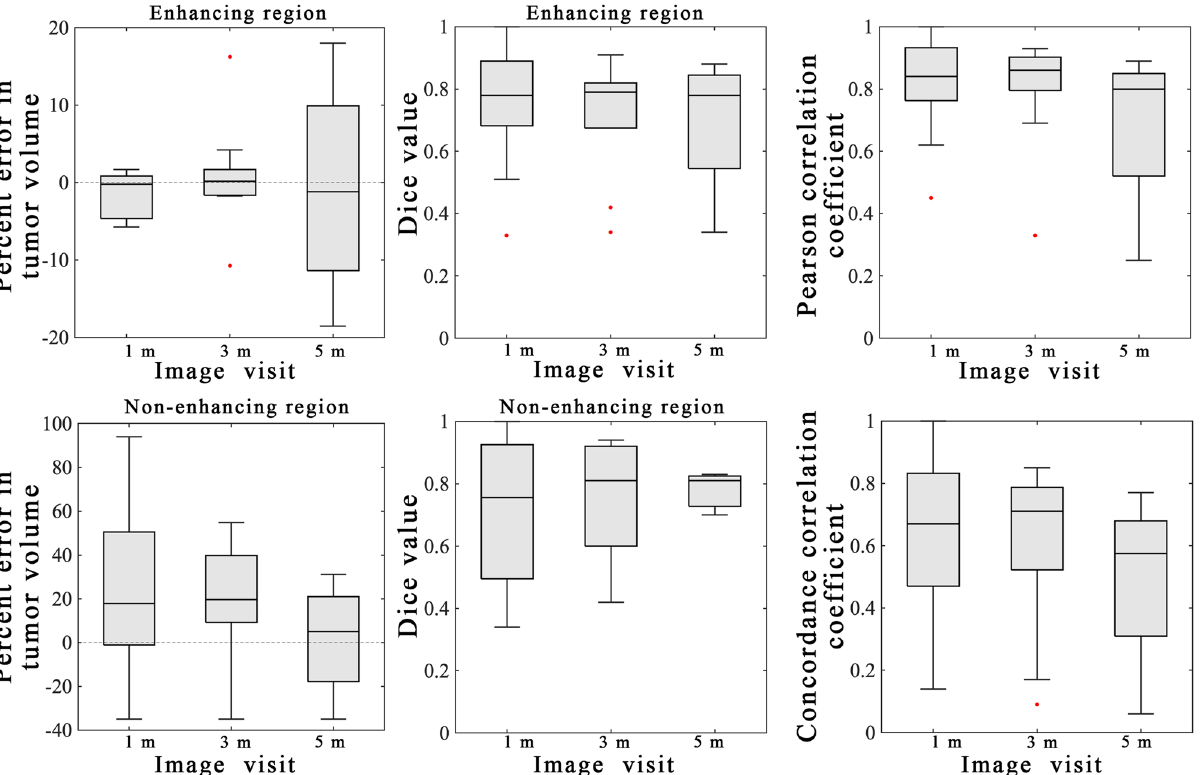
Figure 4. Summary statistics from scenario 1. Error analysis from the model calibration scenario are shown for the entire cohort using the best model. The left column shows the percent error in the tumor volume for the enhancing (top) and non-enhancing (bottom) regions. Greater error was observed in the non-enhancing regions versus the enhancing regions. The middle column shows the Dice values for the enhancing (top) and non-enhancing (bottom) regions. A high level of overlap (median Dice values all greater than 0.76) were observed for the enhancing regions and the non-enhancing regions. The third column shows the results of the voxel-level error analysis for the PCC (top) and CCC (bottom). A high level of agreement and correlation was observed at earlier time points (1-month) versus at later time points (5-month). MATLAB R2019b (Mathworks, Natick, MA) was used for producing individual figures, images, and graphs. Adobe Photoshop 2020 (Adobe, San Jose, CA) was used to arrange individual panels, draw schematics, and add